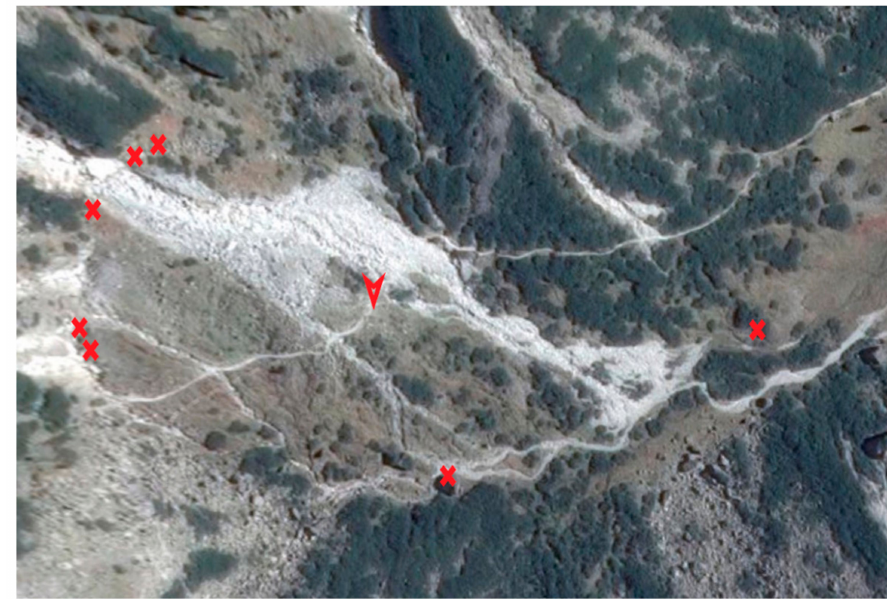
Figure 5. Geodetic network (crosses mark the points of geodetic network and the arrow indicates the position of the total station. Source of map: maps.google.com).